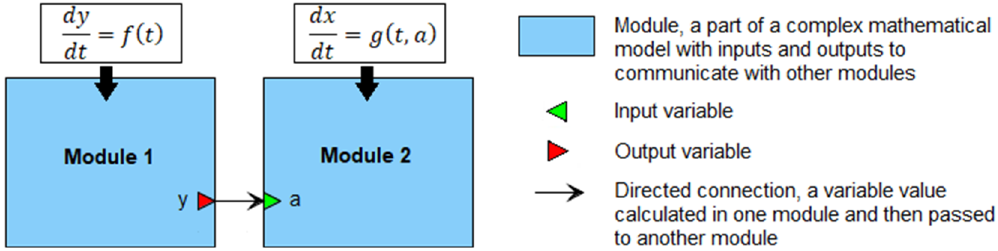
Figure 5. An example of the modular representation of a model that includes two differential equations for x and y . Module 1 calculates the value of y and passes it to Module 2 for initialization of the variable a .